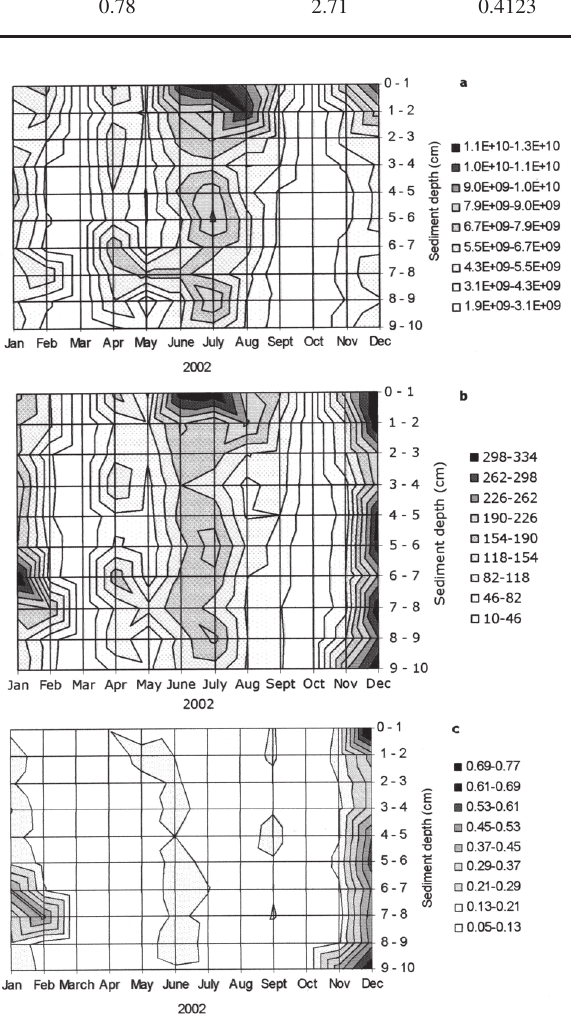
Fig . 4. – the distribution of bacterial abundance (cells g -1 ) in sedi- ment samples (a). the distribution of bacterial biomass (µg c g -1 ) in sediment samples (b). the distribution of the mean cell volume ( µ m 3 ) in sediment samples